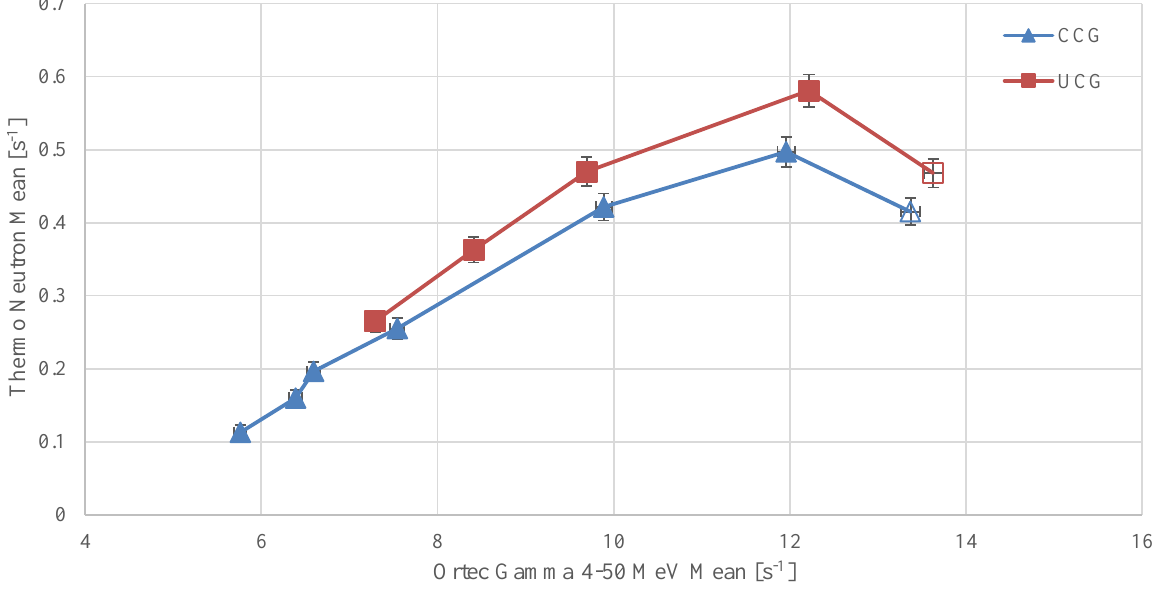
Figure 9. The mean Thermo PackEye neutron count rate as a function of the mean Ortec NaI count rate (between 4 MeV and 50 MeV) at each location in the Central Campus and University Center Garages (CCG and UCG). The data were collected continuously over 15-20 minutes and had a five second rolling average applied before calculating the mean. Data collected from the roof of a garage are denoted by the unfilled points. 1-σ error bars are shown, but some of them may be obscured by the data